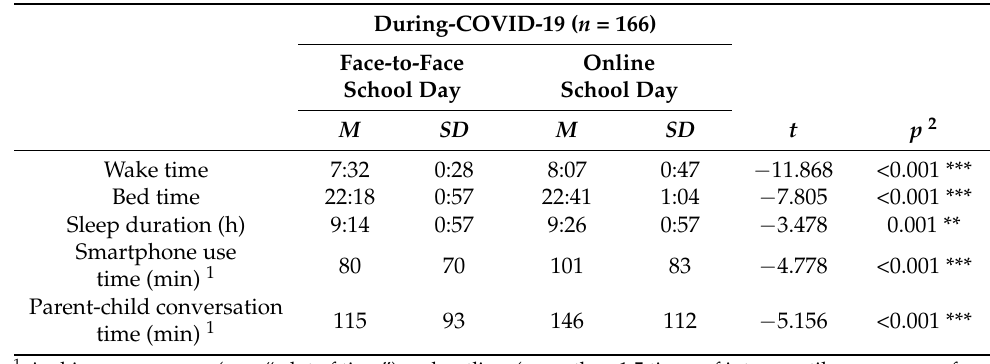
Table 2. Descriptive statistics for daily time use of the during-COVID-19 fourth graders on face-to- face and online school days.